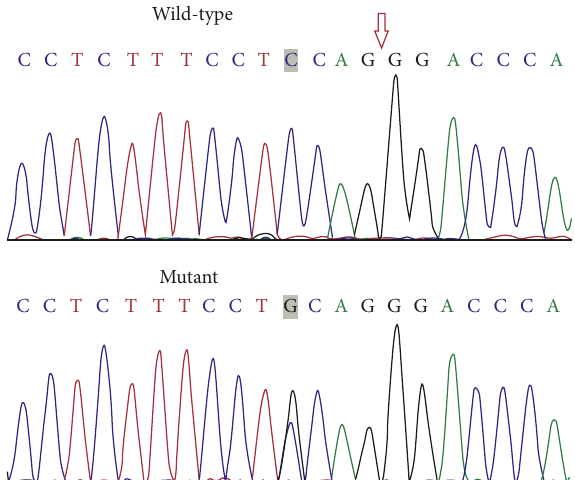
Figure 3: The comparison of the wild-type (III:2) and mutant (III: 4) sequences revealed that the latter harbors a IVS50-4C site mutation. The arrow indicates the exon-intron